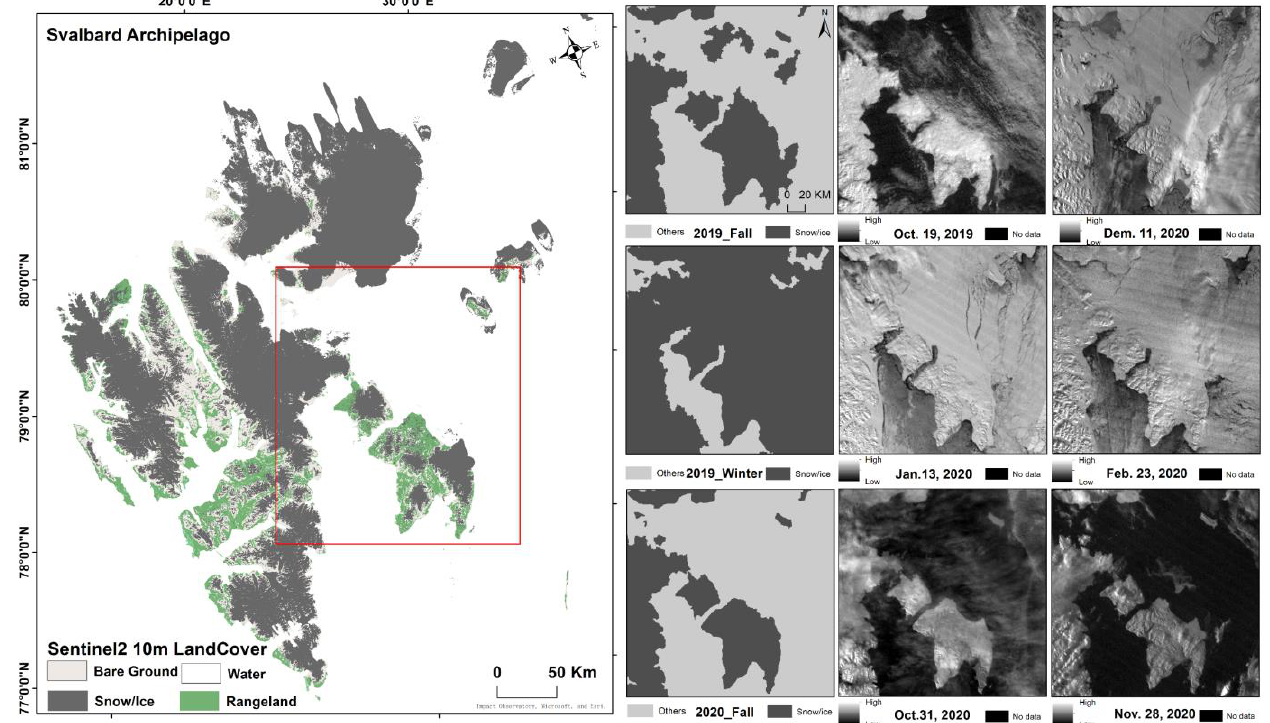
Figure 9. Snow/ice cover change maps from fall 2019 to fall 2020. The snow/ice cover classification accuracy is shown in Figure 10, with the highest classification accuracy being 100.00% in the fall of 2012, 2013, 2018, and 2020. The lowest classification accuracy is 79.75%, and the kappa coefficient is below 0.7 in the winter of 2019. Overall, the moonlight remote sensing images can be used to map the snow/ice cover, with a 96.27% average accuracy and a 0.93 kappa coefficient, respectively.